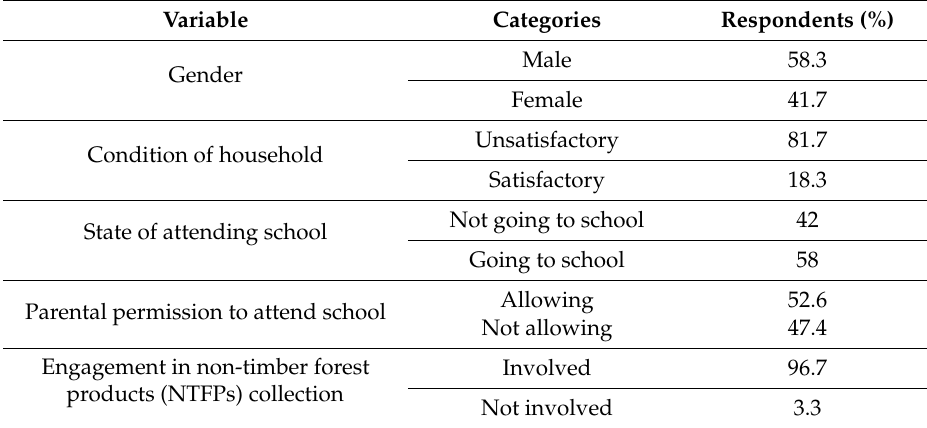
Table 1. Background information and characteristics of the